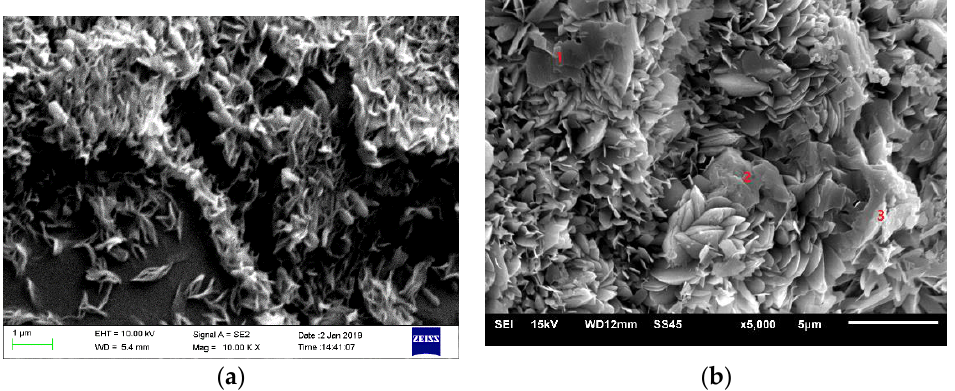
Figure 8. The SEM images of aggregate in concrete microbars cured in 1 mol/L NaOH with 0.83 mol/L LiNO 3 at 80 °C: ( a ) at 42 days; ( b ) at 120 days. LiNO 3 at 80 ◦ C: ( a ) at 42 days; ( b ) at 120